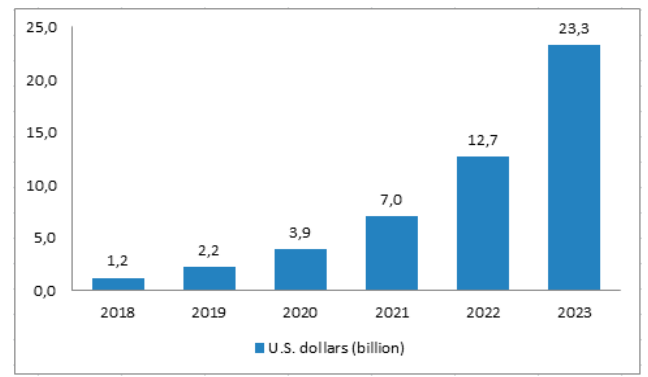
Figure 3. Size of the blockchain technology market around the word (in billion U.S. dollars). Survey period: 2018 to 2023. Publication date: December 2018. Source: statista.com.